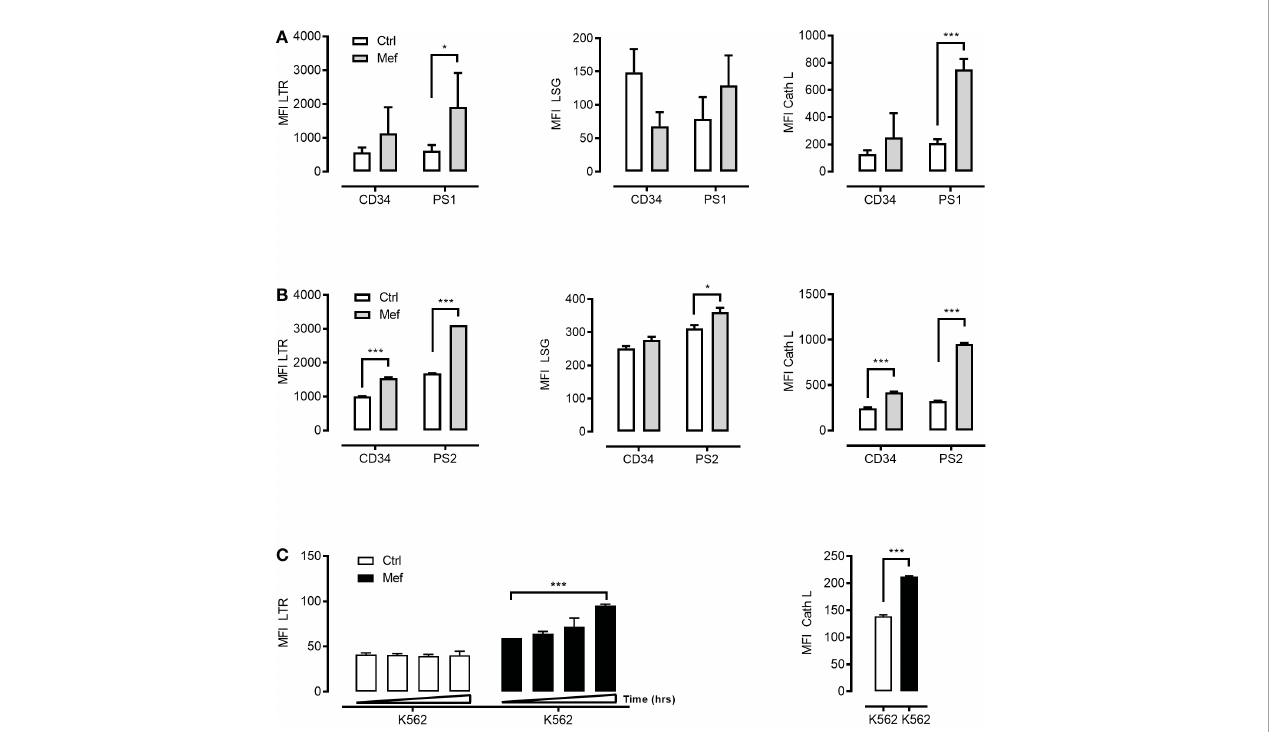
FIGURE 2 Me fl oquine selectively activates lysosomal activity in patients ’ derived leukemic cells. CD34 + cells from healthy donors and patient 1 derived leukemic blasts (PS1) were treated with 10 m M of me fl oquine for 24 h and the effect was measured fl ow cytometrically with LysoTracker Red (LTR) (A) left panel , LysoSensor (LSG) (A) middle panel and Cathepsin L (Cath L) (A) right panel staining. In all three studies, me fl oquine had a higher impact on (PS1) blasts when compared to untreated patient samples and treated and untreated CD34 + cells from healthy donors. Similarly, patient 2 derived leukemic blasts (PS2) and CD34 + cells from healthy donors were treated with 10 m M me fl oquine for 12 h and stained with LTR (B) left panel , LSG (B) middle panel , Cath L (B) right panel . (C) K562 cells were also treated with 10 m M me fl oquine for (12, 24, 36 and 48 h) and found to have signi fi cant time dependent difference on LTR ( left panel ) and Cath L at 24h ( right panel ). Data are presented as mean ± S.D. and are representative for 1-2 independent experiments with one to two replicates. ***p<0.001 Two-way ANOVA with Sidak ’ s multiple comparison test or by student ’ s t-test. *P < 0.05; ***P <